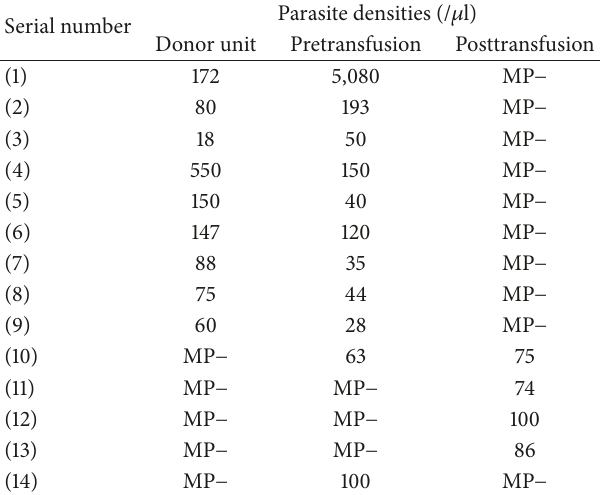
Table 2: Malaria parasite densities in donor-recipient pairs at ABUTH, Zaria ( 𝑛 = 14